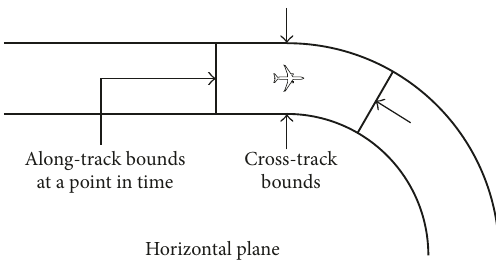
Figure 1: Trajectory bounds in the horizontal plane [12].